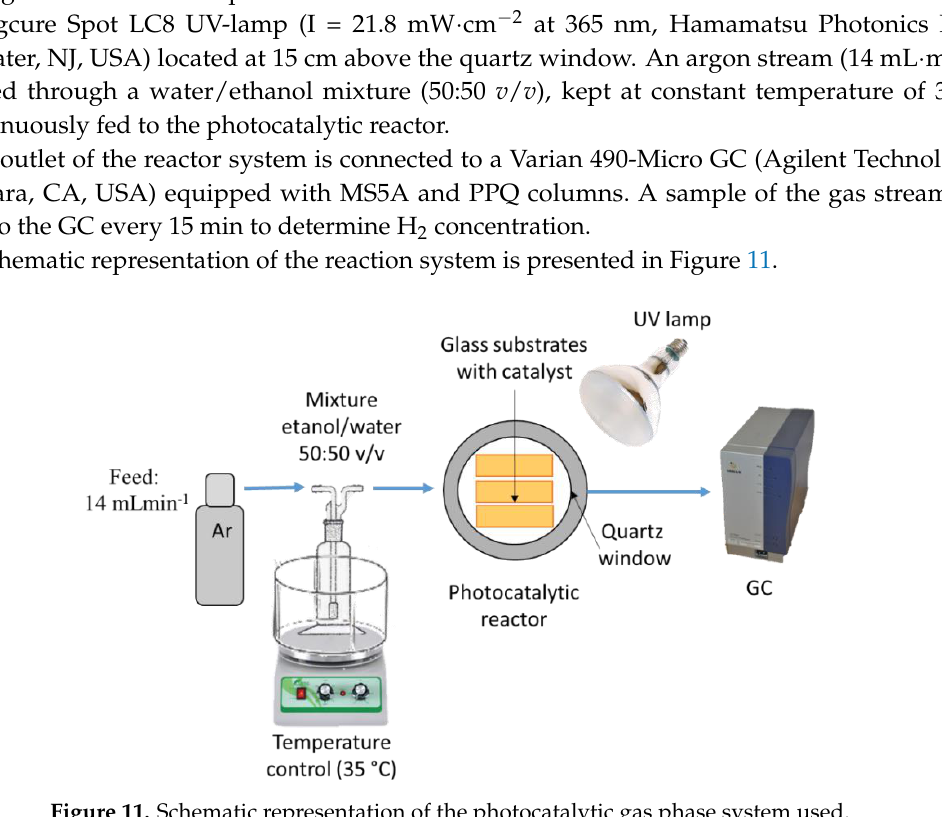
Figure 11. Schematic representation of the photocatalytic gas phase system used.